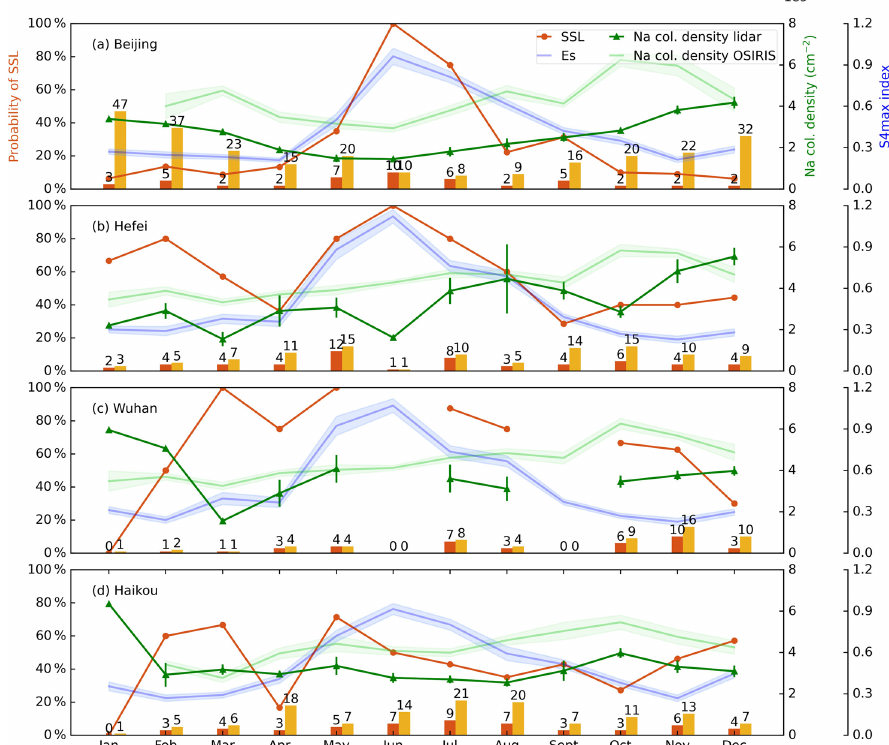
Figure 15. Monthly variations in probability of SSLs per day (orange lines), E s layer intensity represented by S4max at the height of 95– 97km (blue lines), and Na column number density between 76 and 106km from OSIRIS (light green lines) and Na lidars (dark green lines) in 2011/2012, at (a) Beijing, (b) Hefei, (c) Wuhan, and (d) Haikou. The orange and yellow bars in the histogram exhibit the number of SSL nights and total nights measured by lidars. The standard errors of the metallic ion density are represented by the width of the blue shaded area. The standard errors of the monthly Na column number density from OSIRIS and Na lidars are represented by the width of the light green shaded area and the dark green bars. The standard error was calculated from the standard deviations of monthly mean divided by the square root of the number of points in each